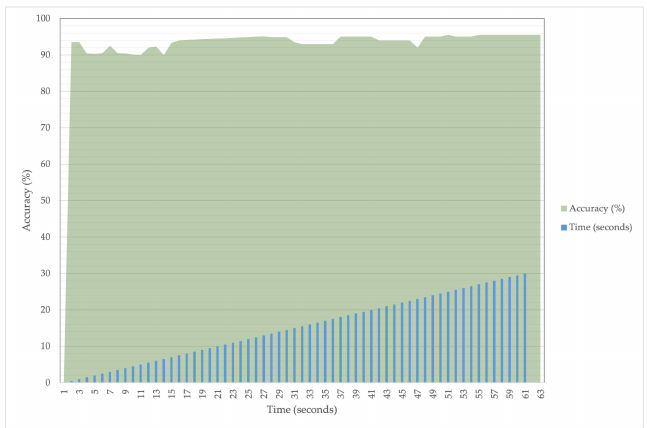
Figure 6. Early Detection Accuracy.